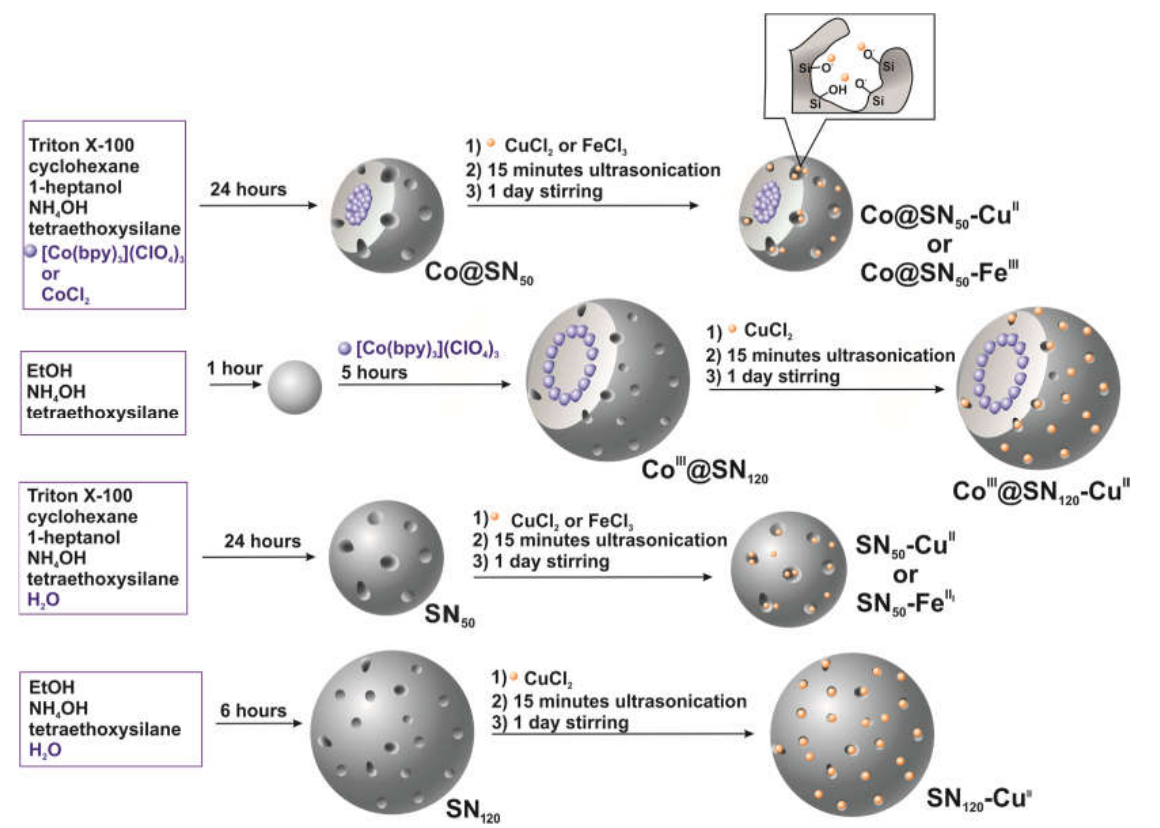
Figure 1. Schematic illustration of the synthesis of Co III @SN 50 , Co III @SN 50 –Cu II (Fe III ), Co II @SN 50 , Co II @SN 50 -Cu II , SN 50 -Cu II (Fe III ), Co III @SN 120 , Co III @SN 120 –Cu II , SN 120 -Cu II through both doping and absorption procedures. Table 1. Si:Co:Cu or Si:Co:Fe Molar ratio by ICP-OES technique and ζ-potential values evaluated by DLS technique for different silica nanoparticles dispersion (0.2 g·L −1 ).